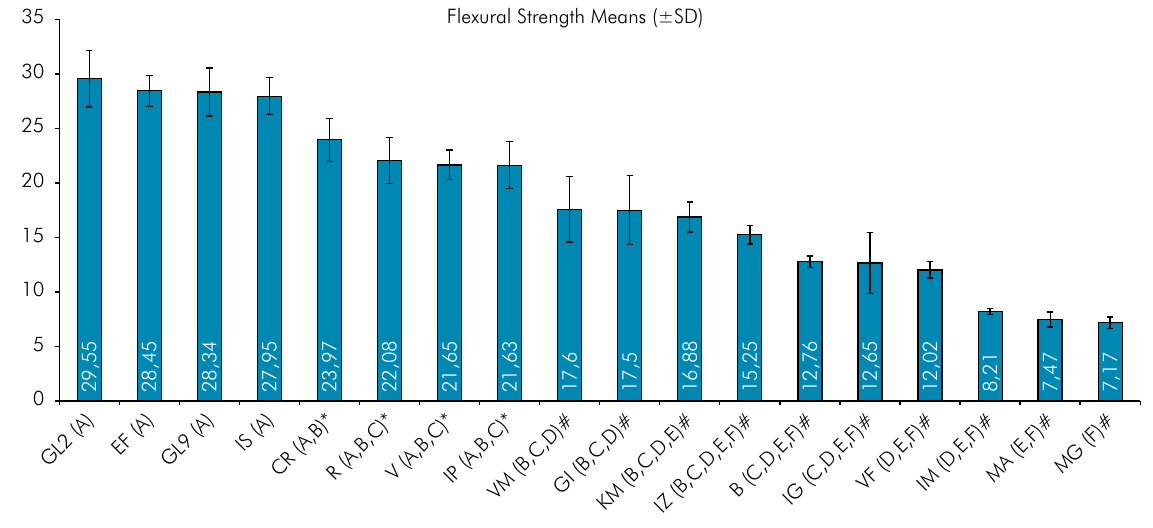
Figure 3. Means and standard deviations for FS of 18 different GICs. Bars with the same letters under them present no statistical difference (p > 0.05). Groups marked with (*) did not reach the cutoff point, but are not statistically different from the brands above it; groups marked with (#) did not achieve the minimum cut off point established and were statistically different from other